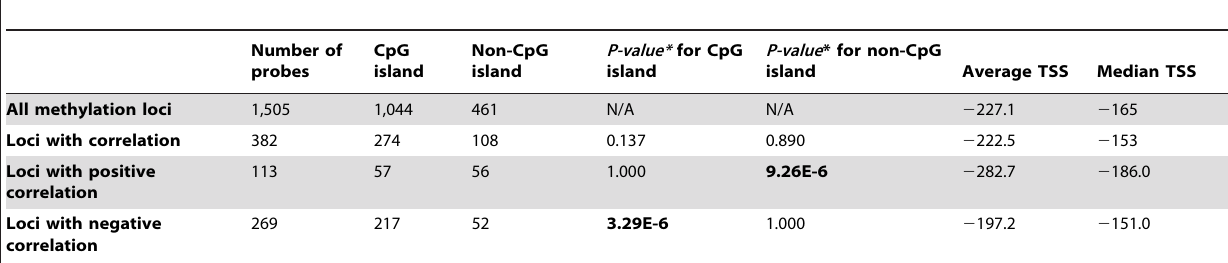
Table 5. Relationship to CpG islands and TSS for genes with methylation-expression correlations identified by the discretization approach